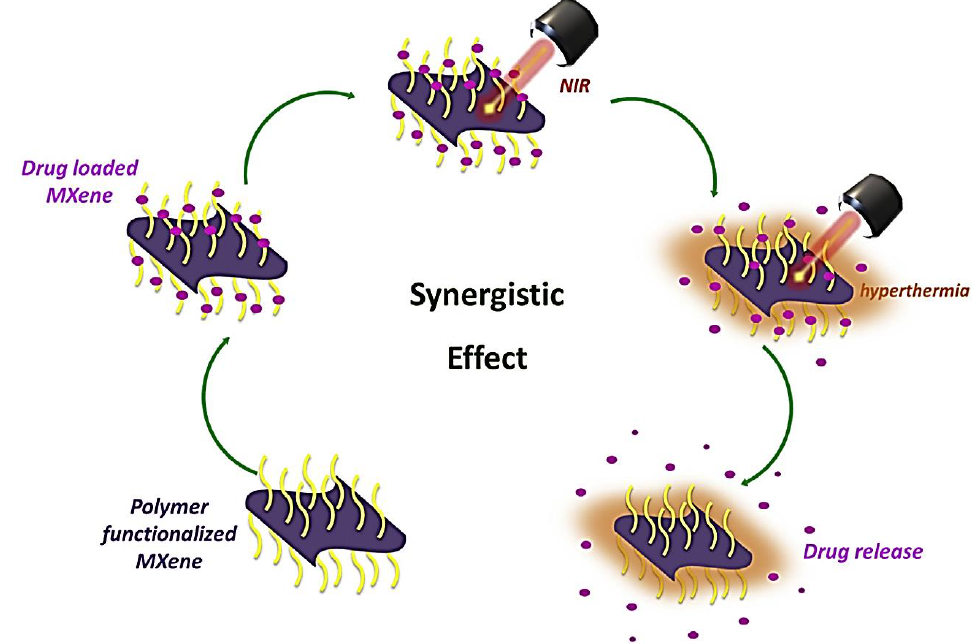
Figure 10. The chemo and photothermal therapy process showing a synergistic effect [11]. Reprinted with permission from Ceramics International. © 2019 Elsevier Ltd. and Techna Group S.r.l.